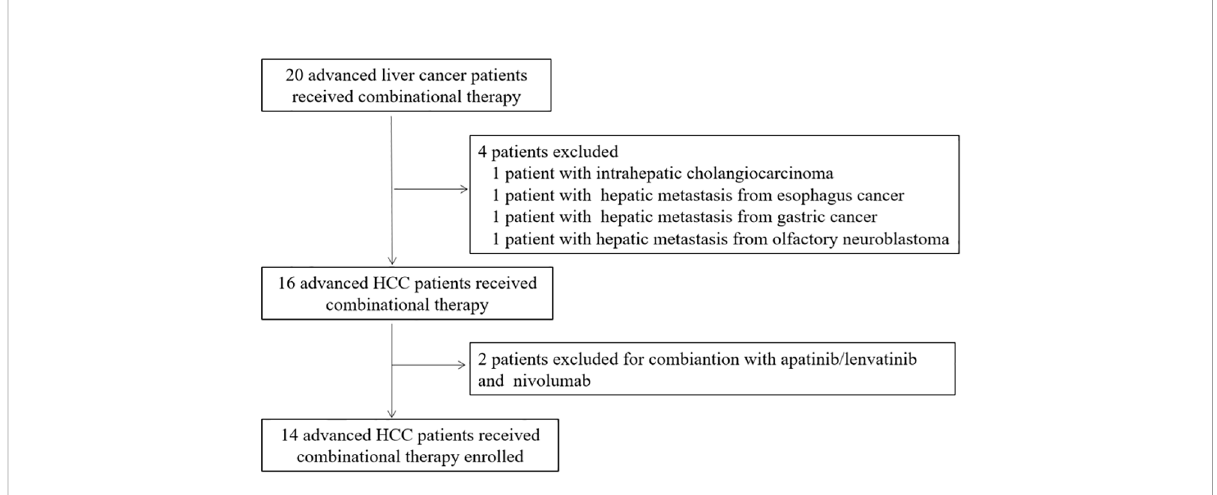
FIGURE 1 Trial pro fi le for patient